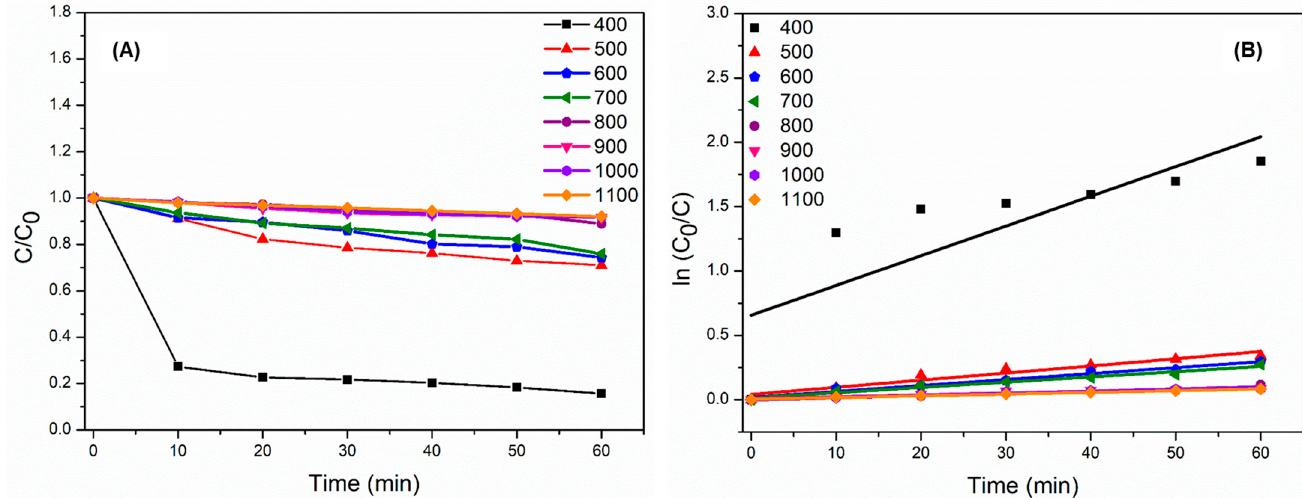
Figure 12. The photocatalytic degradation of the rhodamine B solution under visible irradiation. ( A ) Photocatalytic efficiency curve. ( B ) Graph of ln C 0 / C t versus irradiation time for rhodamine B decomposition for the CuFe 2 O 4 samples. Table 4. Thee experimental photocatalytic data of the decolorization of the rhodamine B solution from the heat-treated CuFe 2 O 4 samples.